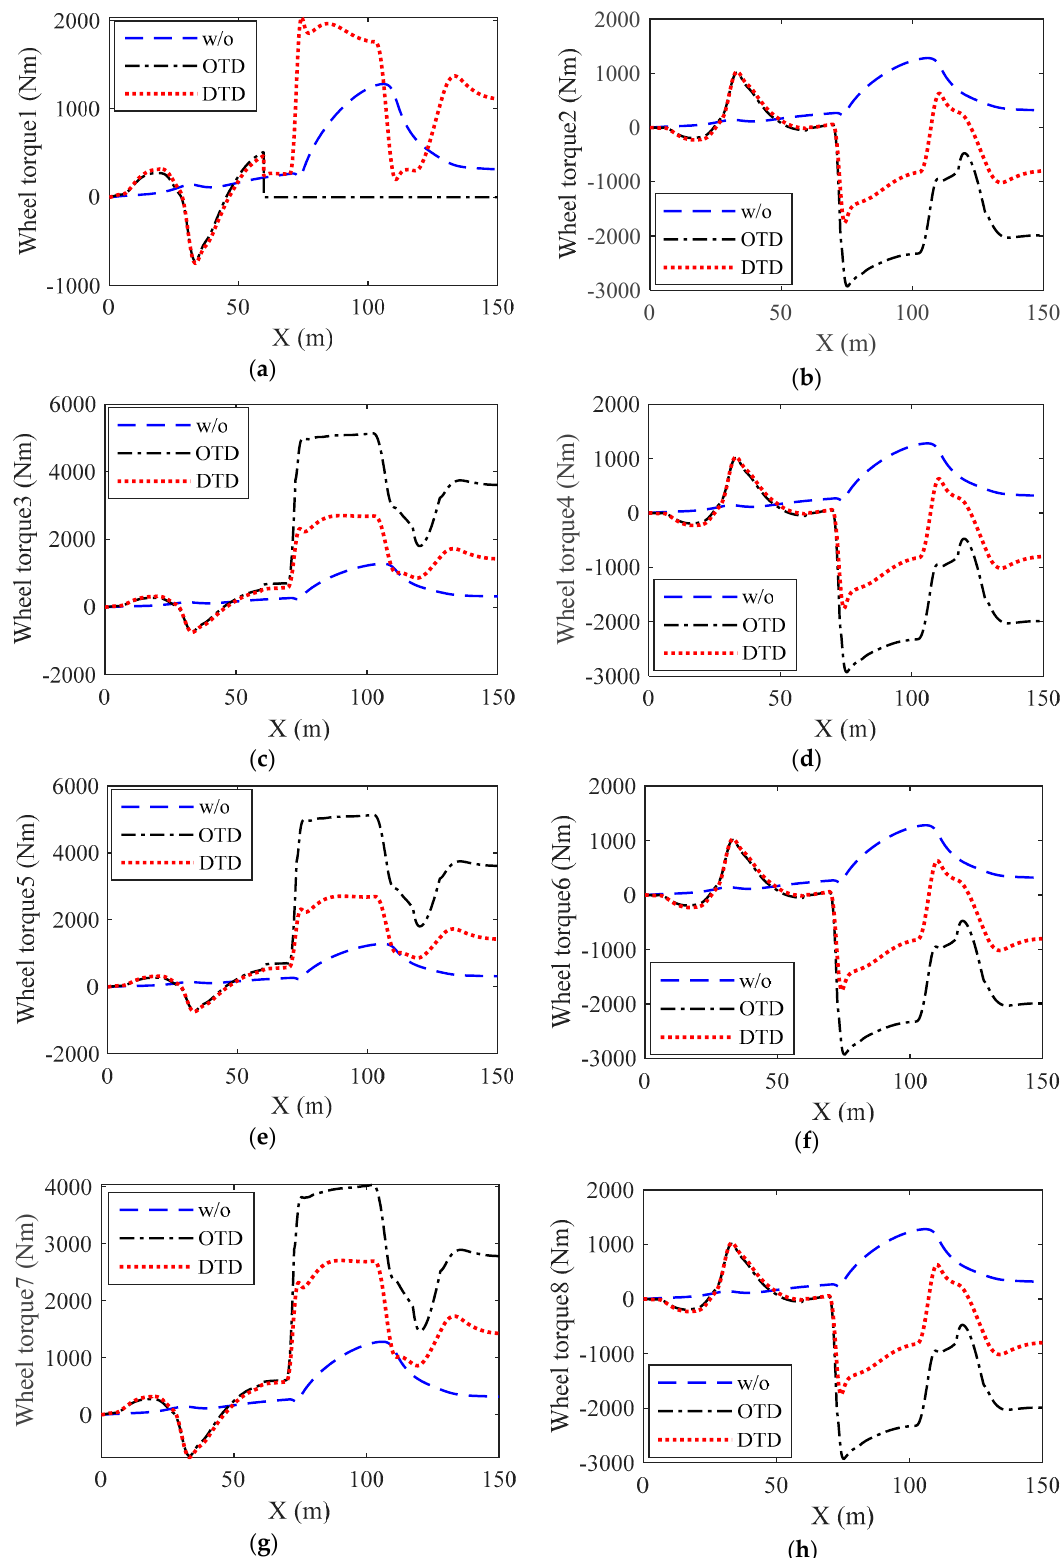
Figure 7. Wheel torque for different control methods. ( a ) Torque of wheel No.1; ( b ) torque of wheel No.2; ( c ) torque of wheel No.3; ( d ) torque of wheel No.4; ( e ) torque of wheel No.5; ( f ) torque of wheel No.6; ( g ) torque of wheel No.7; ( h ) torque of wheel No.8. Different from the vehicle under DTD control, the torque on the failed wheel 1 is zero for OTD controlled vehicle when failure occurs, and thus avoids energy consumption and reduces the disturbance of the driving force on this wheel. Due to the absence of the driving force on the failed wheel and to form the required yaw moment for trajectory correction, drive torques of the normal wheels on the failure side (left side) are significantly larger than that of the normal side (right side). It can be seen more intuitively from the trajectory animation in Figure 8 that vehicles under different control methods separate after entering the right turning lane. The innermost white vehicle is the normal vehicle. The outermost red vehicle is the fail-operation vehicle without control. The second outermost vehicle in yellow is the vehicle under DTD control, and the black vehicle next to the normal one is the vehicle under OTD control. It shows that the direction of the left front and right front wheels are opposite for all failed vehicles, and the vehicle without control travels with the largest trajectory deviation and the slowest velocity. Figure 8. Animation of the trajectories of different vehicles. Compared with the vehicles without control and under DTD control, the OTD controlled vehicle can significantly reduce the tracking error along with the best velocity maintaining ability, which verifies the effectiveness of the proposed fail-operation control strategy.